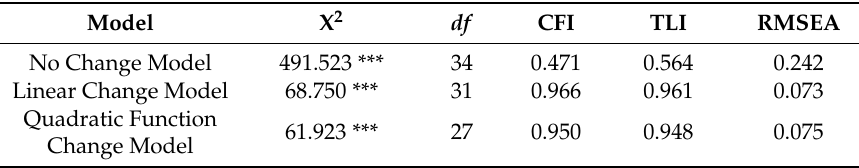
Table 2. Fitness for Latent Growth Modeling of Suicide